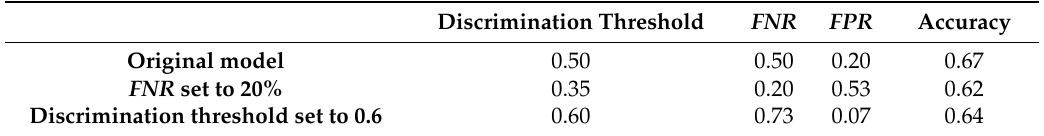
Table 3. The connection between the discrimination threshold, false negative rate ( FNR ), false positive rate ( FPR ), and